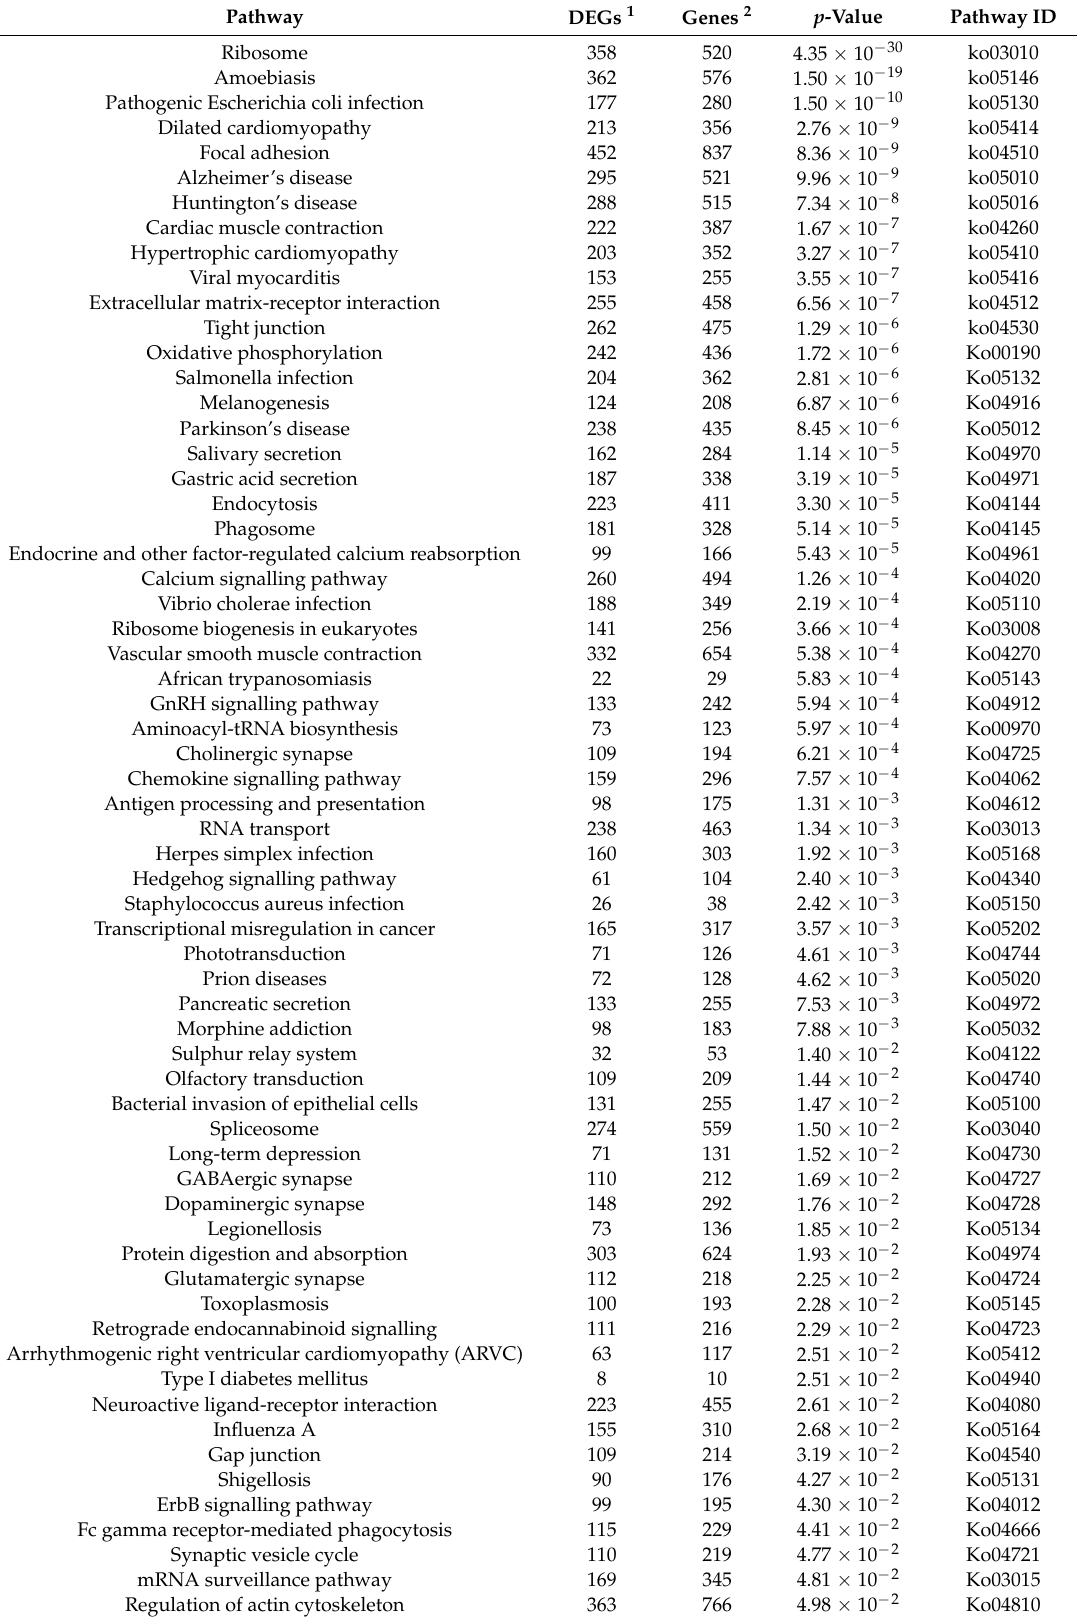
Table 2. KEGG pathways’ enrichment analysis in the Bursaphelenchus mucronatus ( B. mucronatus )